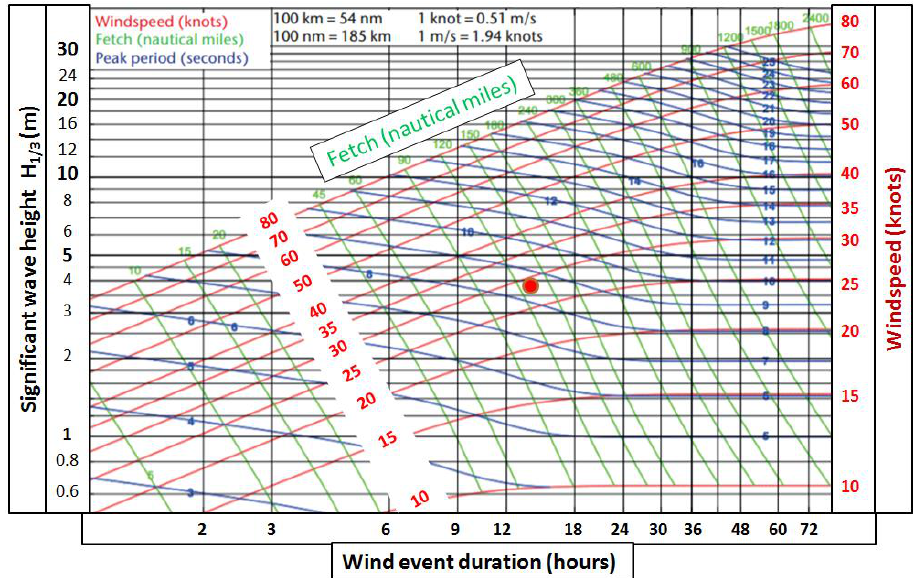
Figure 15. Significant wave height of the study event (red point) evaluated with the nomogram modified by Breugem-Holthuijsen [30].